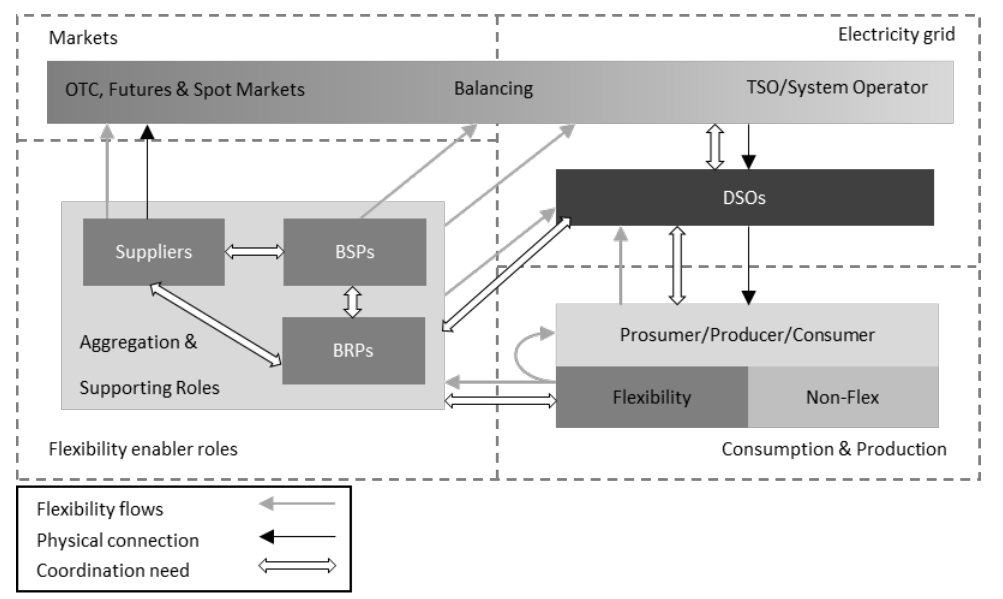
Figure 3. Stakeholder overview showing the flow of flexibility.